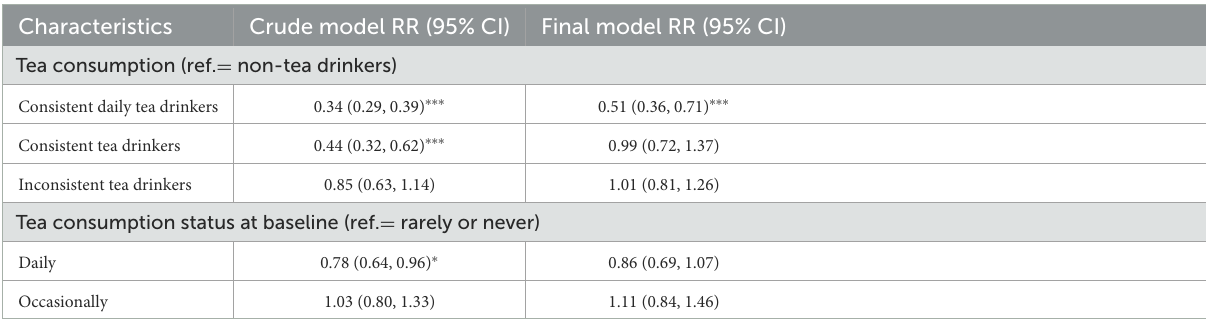
TABLE 2 Associations between tea consumption and frailty among older Chinese people. Characteristics